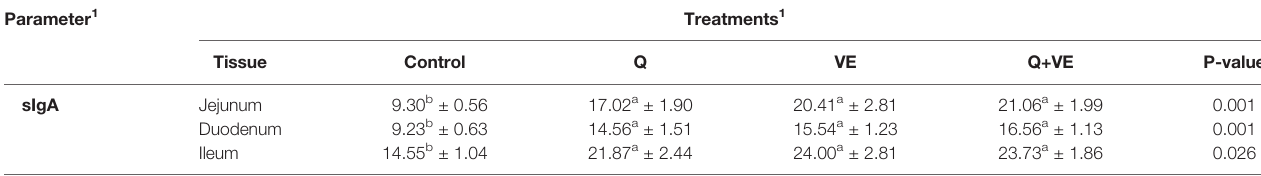
TABLE 4 | Effects of supplemental Q, VE, and Q + VE on the immune biomarker (sIgA) levels in the intestinal mucosa of the aged breeder hens. Parameter 1